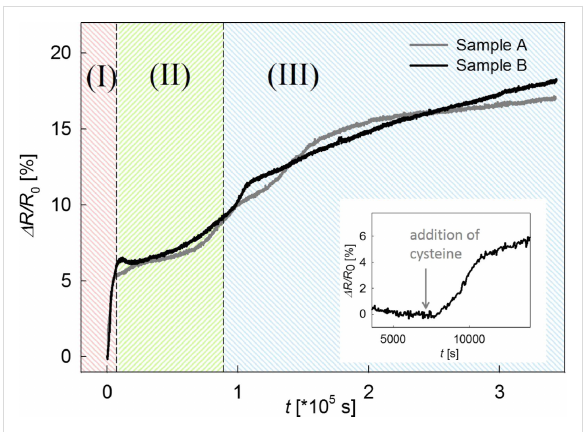
Figure 1: Relative change in electrical resistance measured in situ during the exposure of npAu in 20 mM cysteine solution. Inset: Enlarged first few hours of the resistance change of sample B. After 2 h in ultrapure water, cysteine was added (marked by the grey